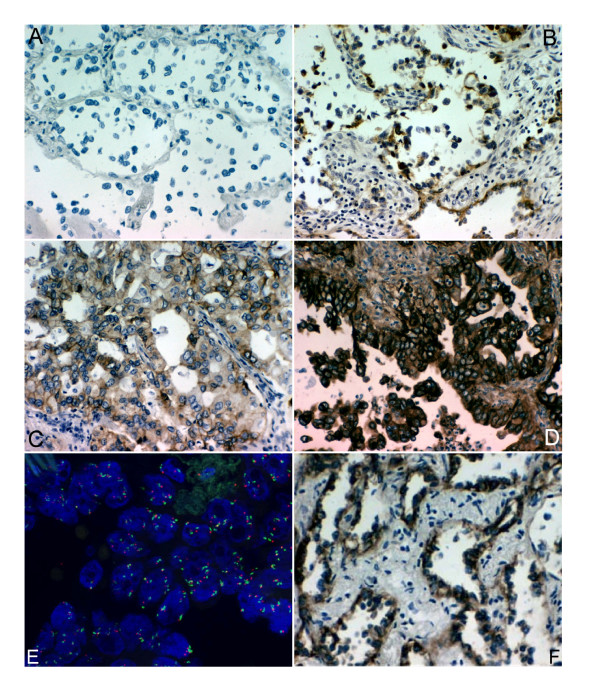
Quantitative and qualitative assessment of EGFR status. A-D: Immunohistochemical stain for EGFR of primary lung adenocarcinoma (magnification: 200×). A) No membranous or cytoplasmic stain. B) Weak mostly incomplete membranous stain combined with moderate cytoplasmic stain. C) Moderate mostly incomplete membranous stain combined with weak cytoplasmic stain. D) Strong mostly complete membranous stain combined with strong cytoplasmic stain. E and F: E) Fluorescence in-situ hybridization for EGFR (locus 7p12, red) and CEP7 (locus 7p11.1-q11.1, green) of primary lung adenocarcinoma showing no amplification of the EGFR-gen. F) Corresponding immunohistochemical stain for EGFR showing strong mostly incomplete membranous staining combined with moderate cytoplasmic staining.